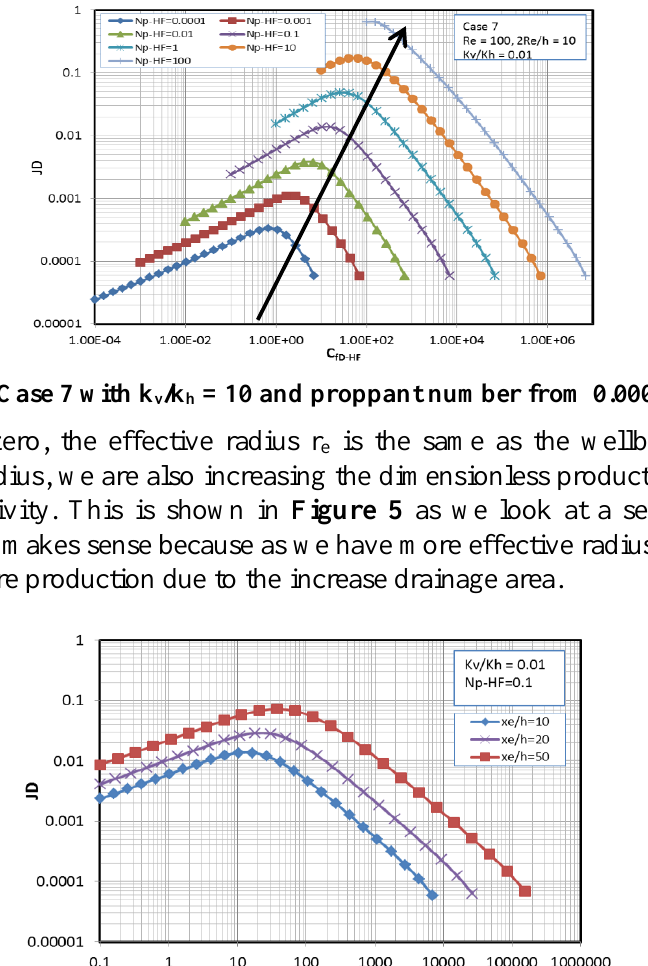
Figure 5—Sensitivity Analysis with varying values of effective radius.